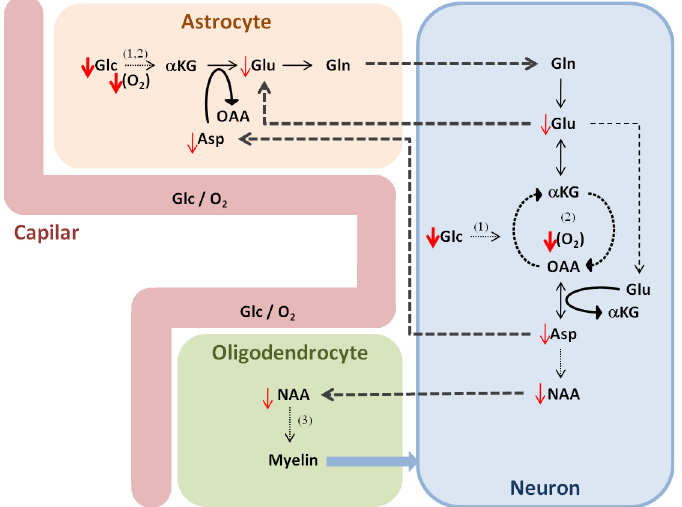
Fig 4. Metabolic model of IUGR impairment in cortex and hippocampus regions. Sustained hypoxemia (lower oxygen, O 2 ) and under-nutrition (lower glucose, Glc) during IUGR lead to impaired brain metabolism, noticed in vivo as a decrease in products of aerobic metabolism (tricarboxylic acid cycle and oxidative phosphorylation (2)): Asp, NAA, and Glu. Basic metabolite shuttling between neurons and glial cells according to the literature [50,51,52]. (1) Glycolysis; (3) fatty acid synthesis; alpha-ketoglutarate ( α KG); glucose (Glc); oxaloacetate